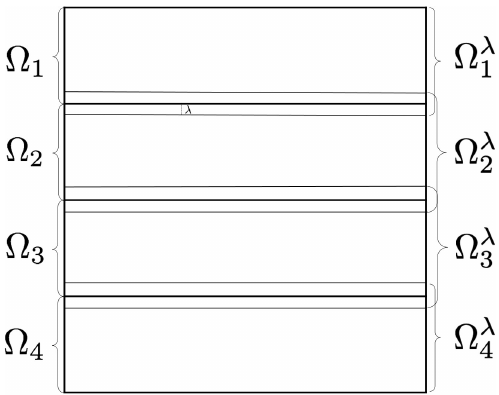
Figure 2. Overlapping domain decomposition using four